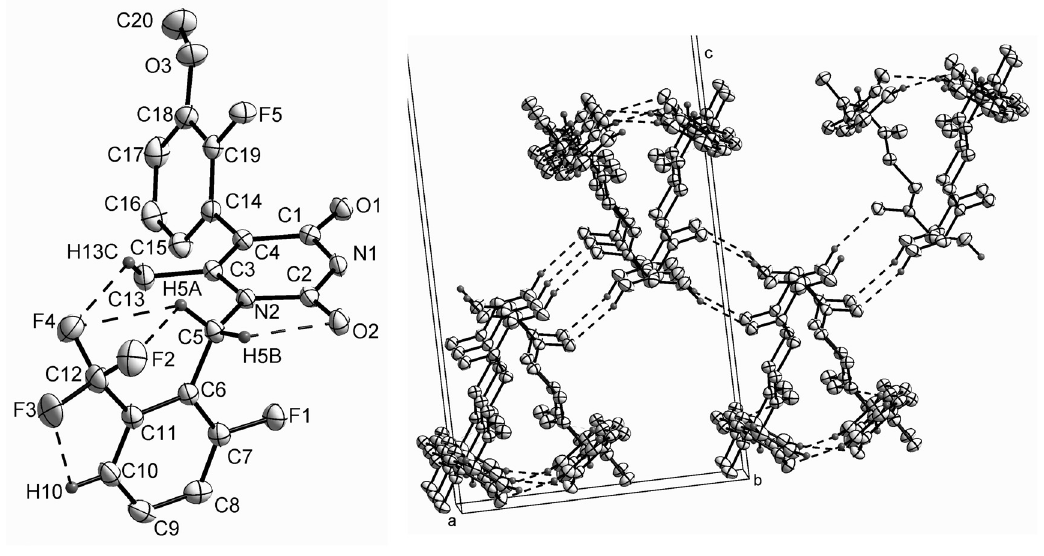
Table  : Data collection and handling.